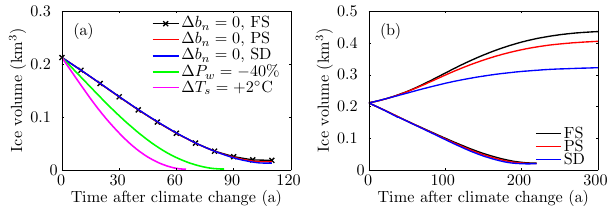
Fig. 8. Response of Haig Glacier to an idealized step change in climate. (a) Evolution of ice volume under no-change and negative mass balance scenarios. Results for the latter cases are from the FS model simulation. (b) Evolution of ice volume under positive mass balance scenarios. The advancing lines represent the 1T s = − 2 ◦ C scenario, and retreat cases are for the 1P w = + 40%